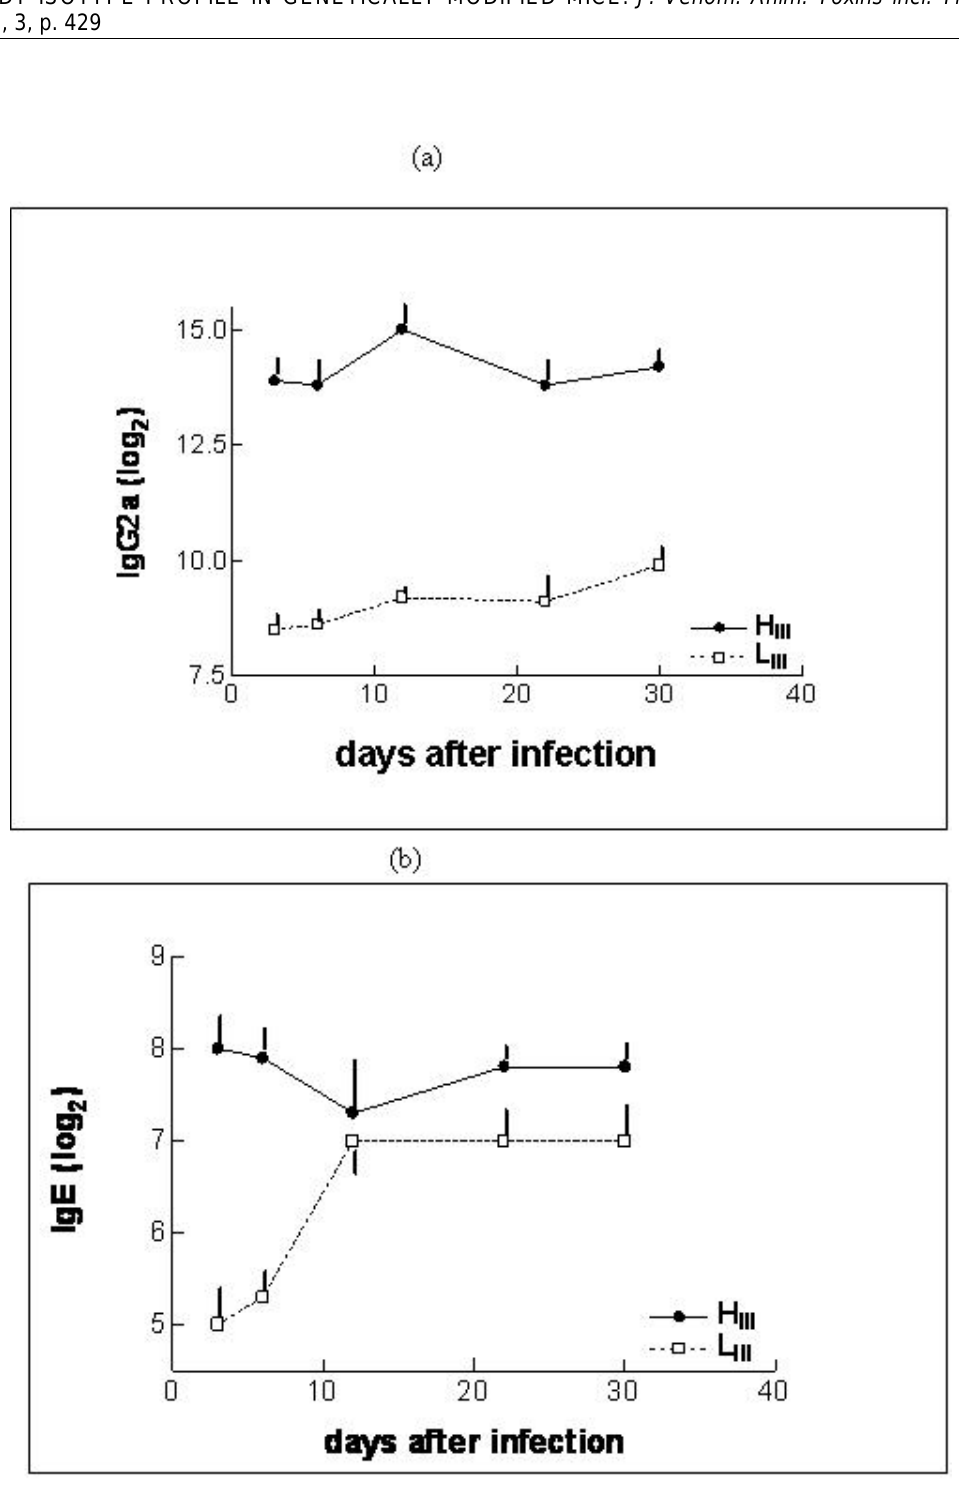
and L responder mice III III /0.03ml); sera were collected on days 3, 6, 12, 50